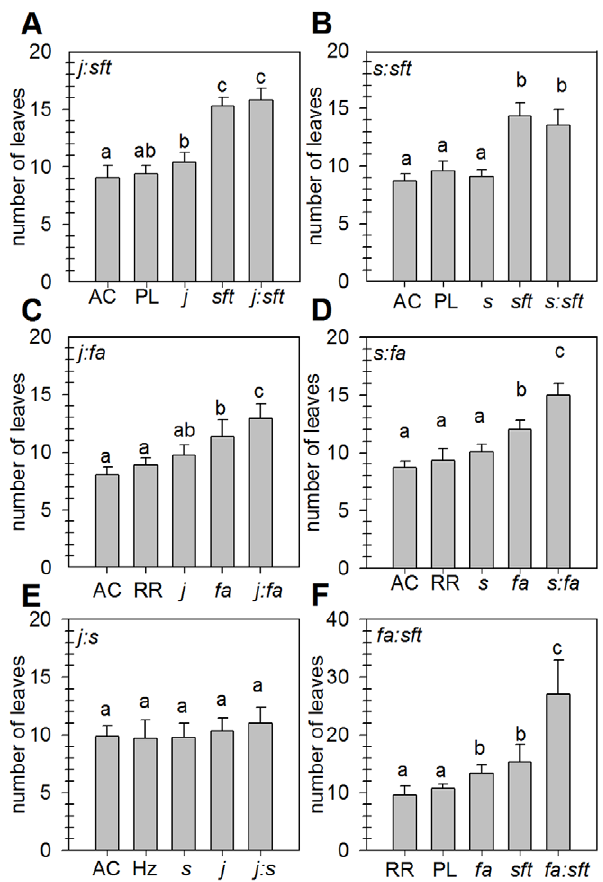
Figure 1. Flowering time (expressed as number of leaves below the first inflorescence) of tomato double mutants. (A) j:sft ; (B) s:sft ; (C) j:fa ; (D) s:fa ; (E) j:s ; and (F) fa:sft . Values followed by a same letter (a, b, or c) are not statistically different (P , 0.05). Genotype abbreviations: AC, Ailsa Craig WT; fa , falsiflora ; Hz, Heinz WT; j, jointless ; Pl, Platense WT; RR, Rheinlands Rhum WT; s , compound inflorescence ; sft , single flower truss . The j mutant is in AC background in A and C, in Hz background in E. doi:10.1371/journal.pone.0031096.g001 PLoS ONE |